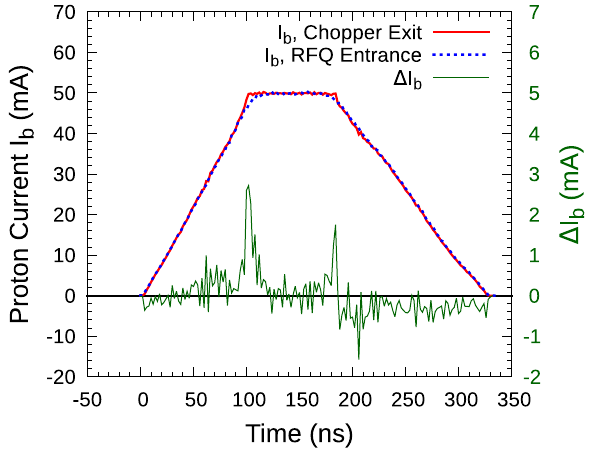
FIG. 6. Simulated pulse shape for 120 keV protons directly behind the chopper (red) and at the RFQ entrance (blue). The ¼ I chopper − I rfq difference Δ I is depicted in green. No relevant b b b increase of the pulse length is observed.